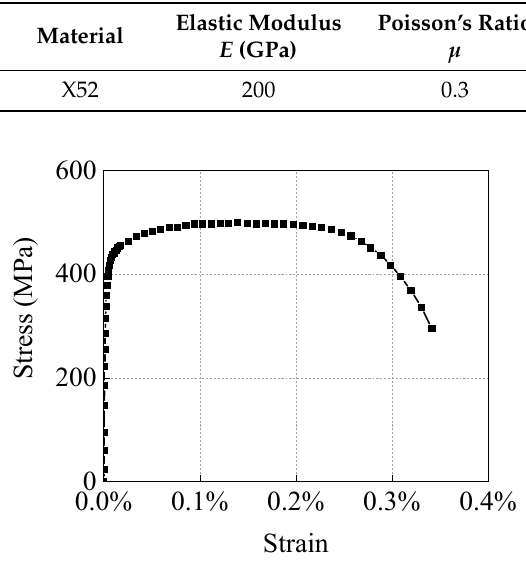
Table 1. Mechanical parameters of pipe for testing.